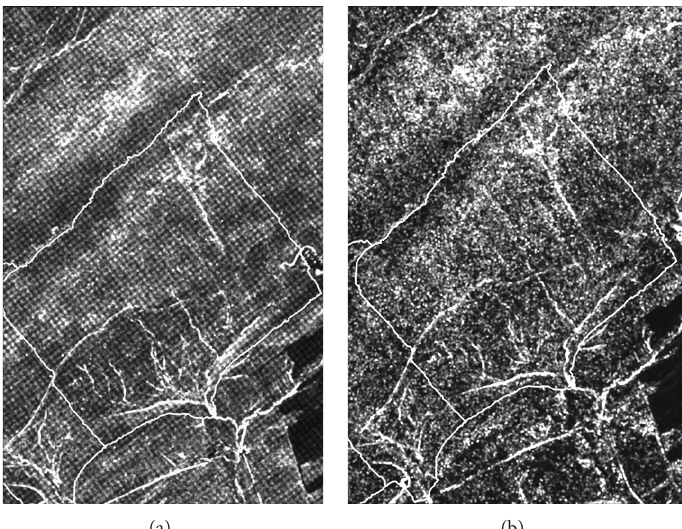
Figure 8: Standard deviation of curvature values for CZO LiDAR (a) and PAMAP LiDAR (b). White areas correspond to high roughness values.